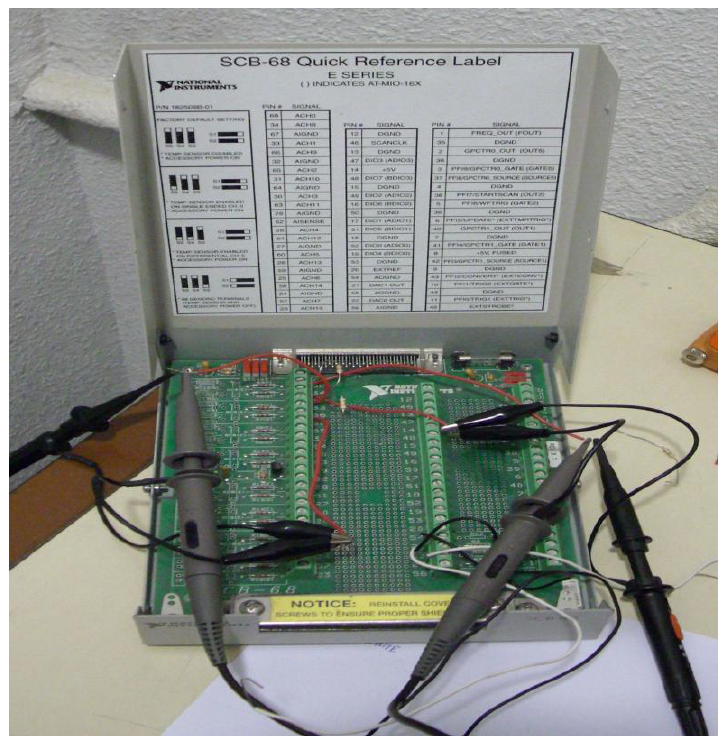
Figure 2. NI SCB-68 connector